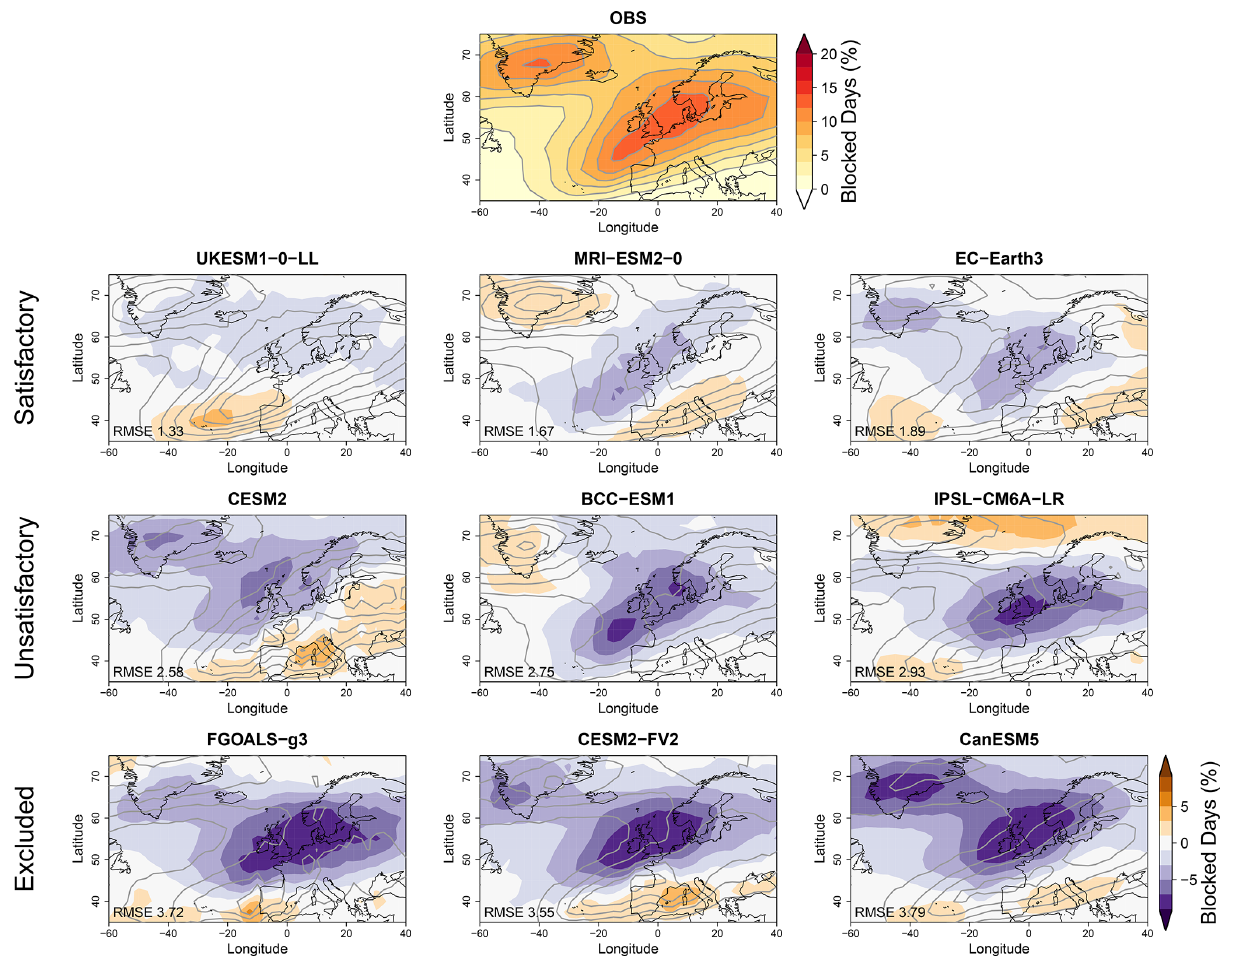
Figure A8. Examples of DJF blocking-frequency classifications for a sample of individual models.